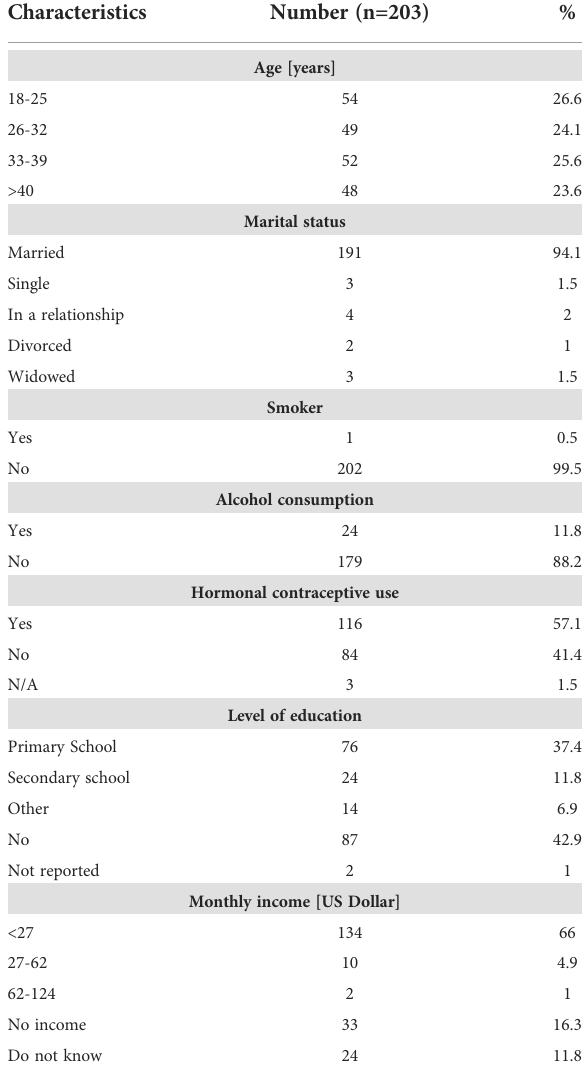
TABLE 1 Characteristics of enrolled